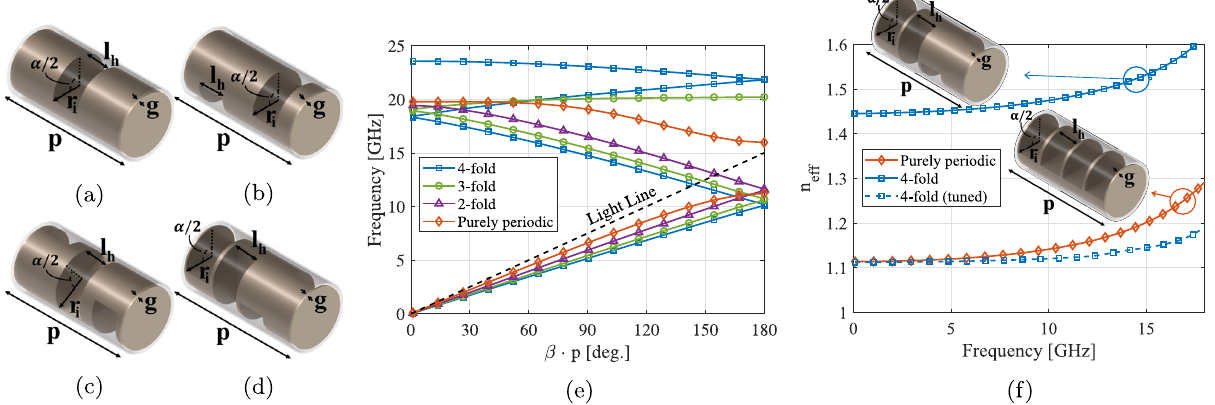
Fig. 2. Simulated perfect twist-symmetric structures with hole-type deformations: Studied structures: (a) purely periodic, (b) 2-fold, (c) 3-fold, and (d) 4-fold. (e) Dispersion diagram using the dimensions: a = 180 (cid:3) , l h = 2.2mm, r i =2.3 mm, g = 0.2 mm, and p =10 mm; (f) Effective refractive index comparison of the purely periodic and 4-fold twist-symmetric structures with dimensions: a =180 (cid:3) (tuned: a =85 (cid:3) ), l h = 2.2 mm, r i =2.3 mm, g =0.2 mm, and p